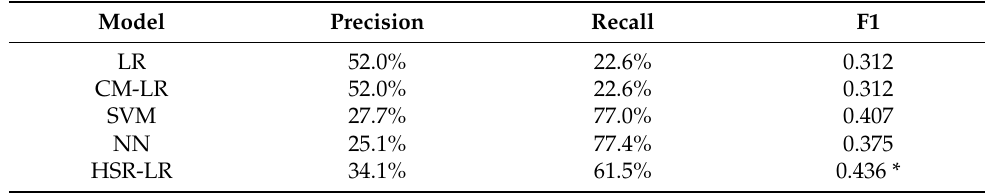
Table 9. Results on